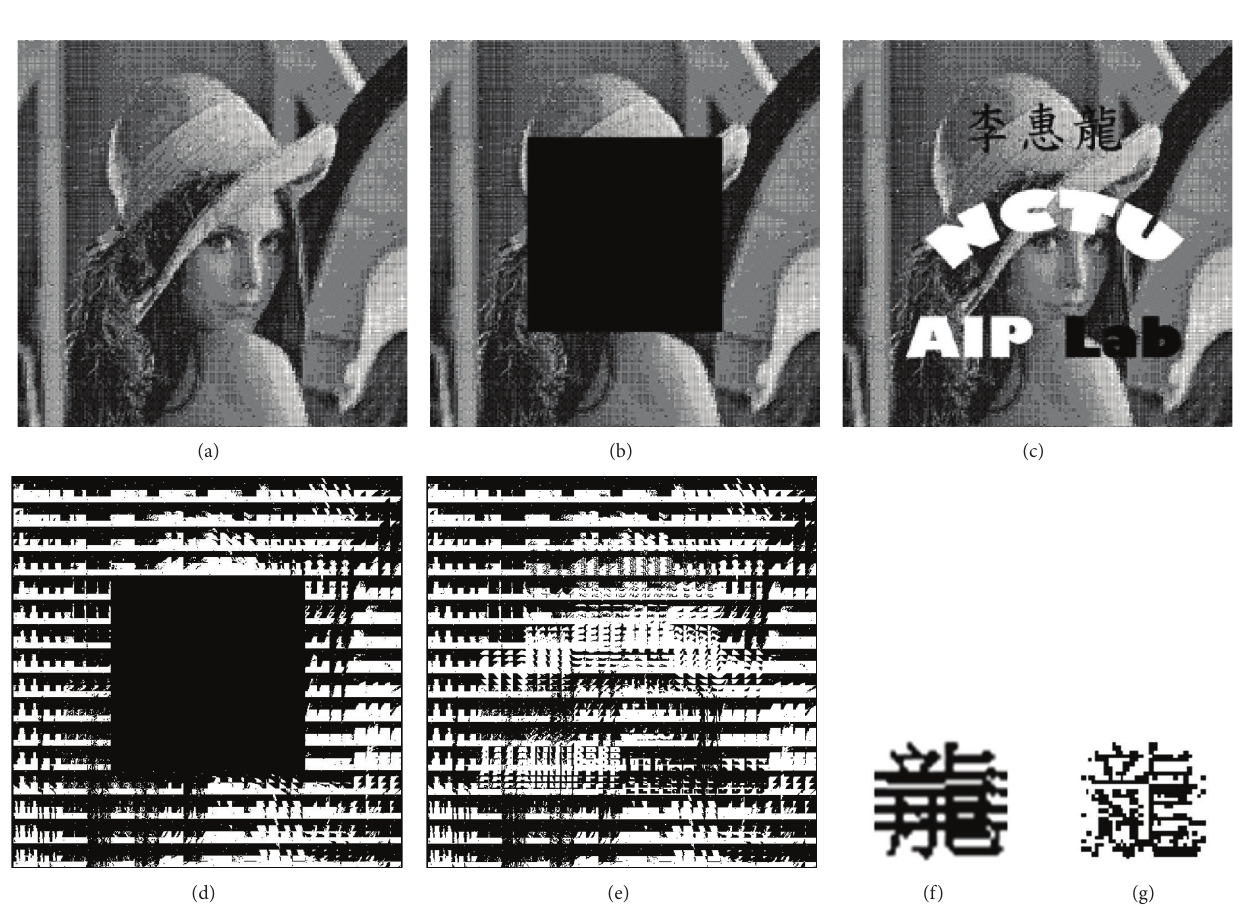
Figure 11: The robustness of Guo et al.’s method [12]. (a) Embedded dithered image using Guo et al.’s method. (b) Embedded dithered image cropped by 1/4 portion. (c) Embedded dithered image with tampering. (d) The result of applying bit-interleaving to each subimage of (b). (e) The result of applying bit-interleaving to each subimage of (c). (f) The watermark extracted from (b). (g) The watermark extracted from